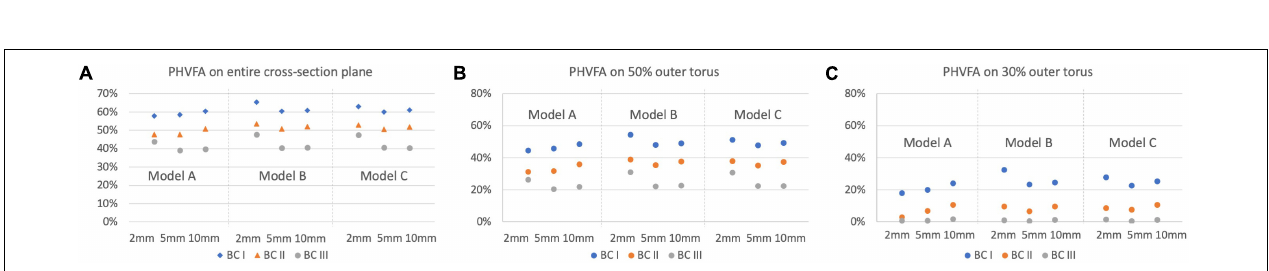
FIGURE 8 | Comparison of the PHVFA of flush flow on different cross-sectional planes and the corresponding 30 and 50% outer torus, under three flowrates of the background blood flow, for Models A, B, and C. (A) PHVFA on the entire cross-sectional plane. (B) PHVFA on 50% outer torus. (C) PHVFA on 30% outer torus.